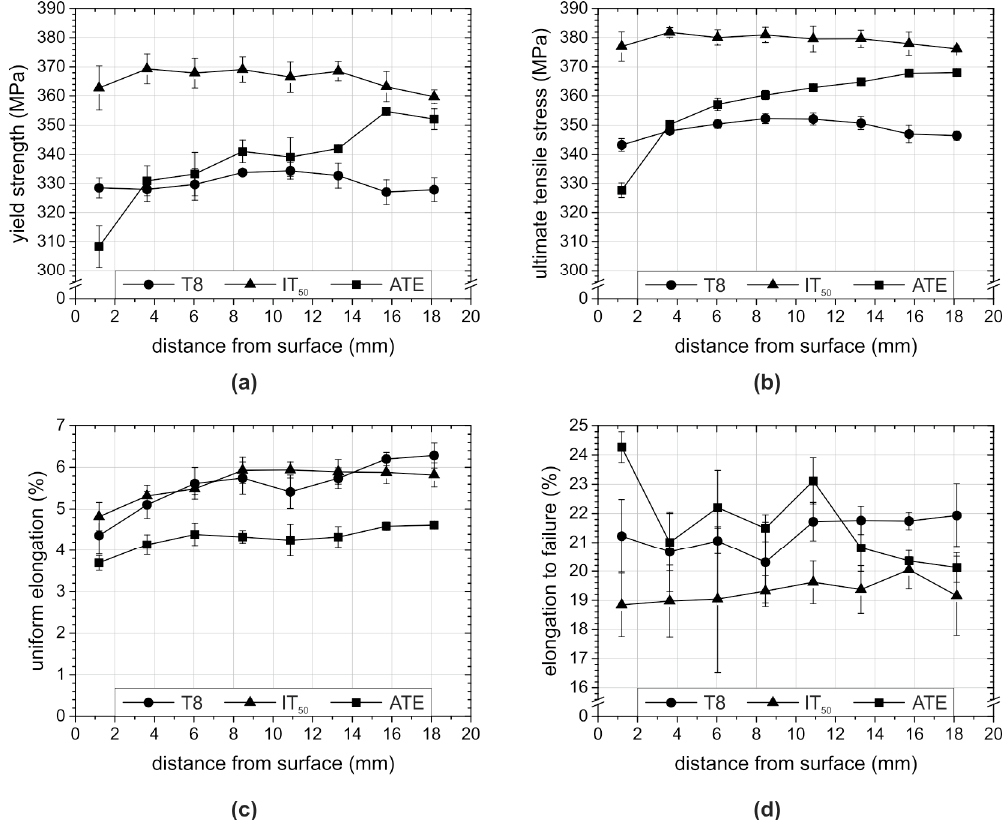
Figure 7. Overview of the tensile properties of the optimized conditions T8 (RT-extrusion and peak aged, circles), IT 50 (IT-extrusion and aged for 50 min, triangles) and ATE (AT-extrusion, as-extruded, squares) as a function of distance from the surface. ( a ) Yield strength; ( b ) ultimate tensile strength; ( c ) uniform elongation; and, ( d ) elongation to failure.